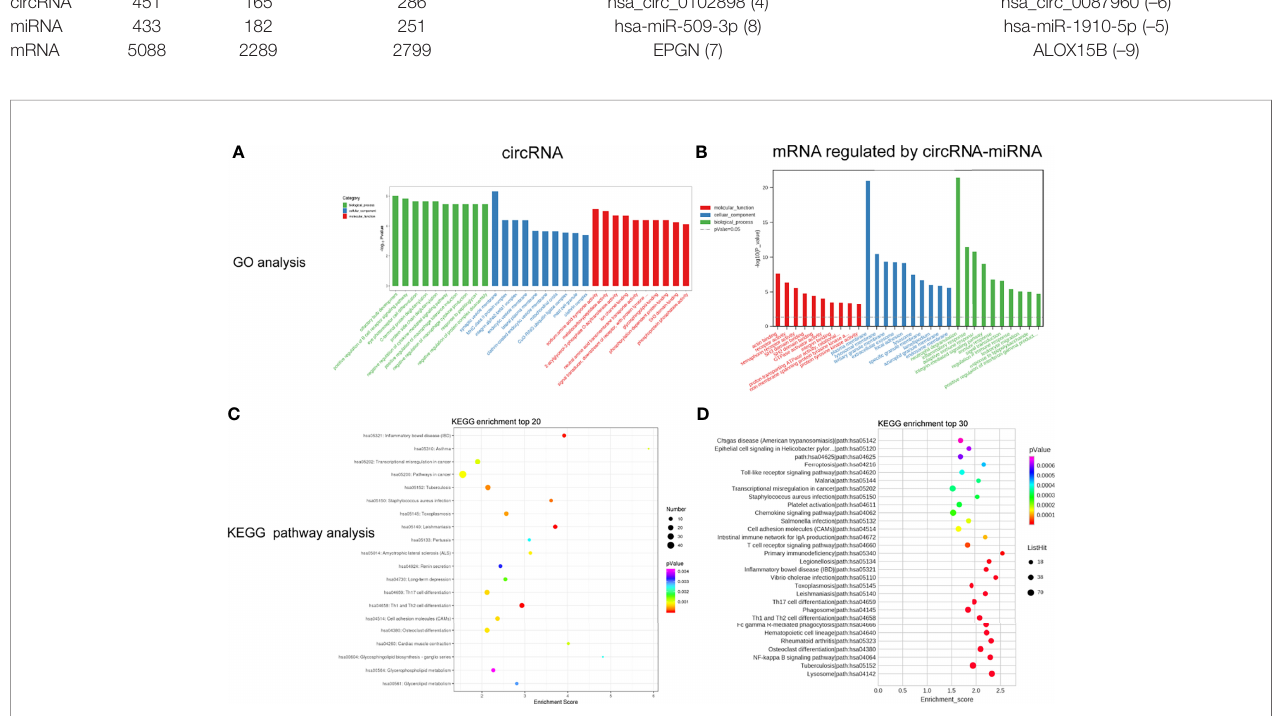
TABLE 2 | The most signi fi cantly upregulated and downregulated circRNAs, miRNAs and mRNAs. DE RNAs The Most Upregulated [log2(fold-change)] The Most Downregulated [log2(fold-change)]